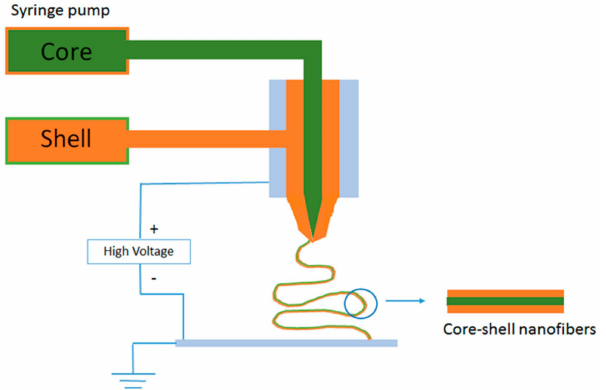
Figure 3. Co-axial electrospinning setup for generating core-shell